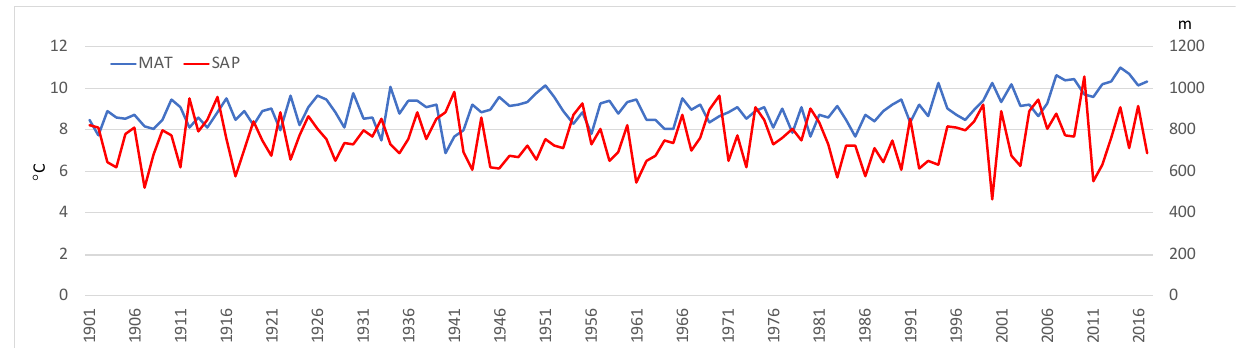
Figure 4. Variation of the mean annual temperature (MAT) and sum annual precipitation (SAP) in 1901–2017 period.